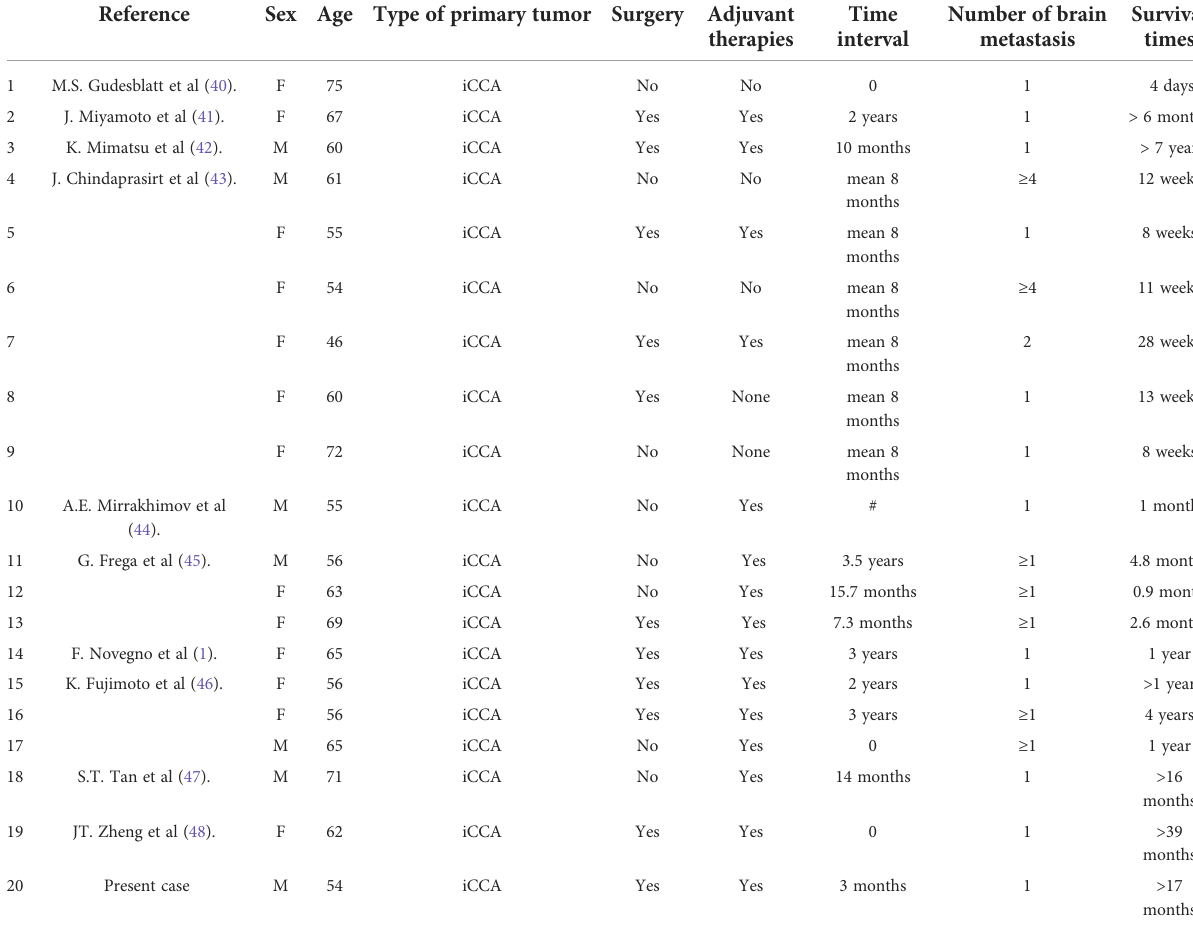
TABLE 1 Case reports summary of the iCCA patients with brain metastasis (iCCA: intrahepatic cholangiocarcinoma). Reference Sex Age Type of primary tumor Surgery Adjuvant